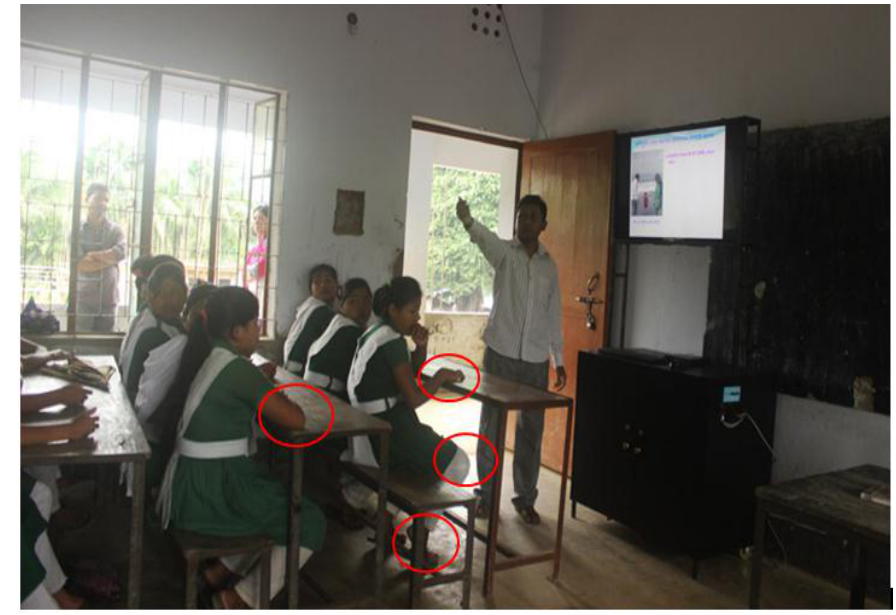
Figure 3. Existing furniture